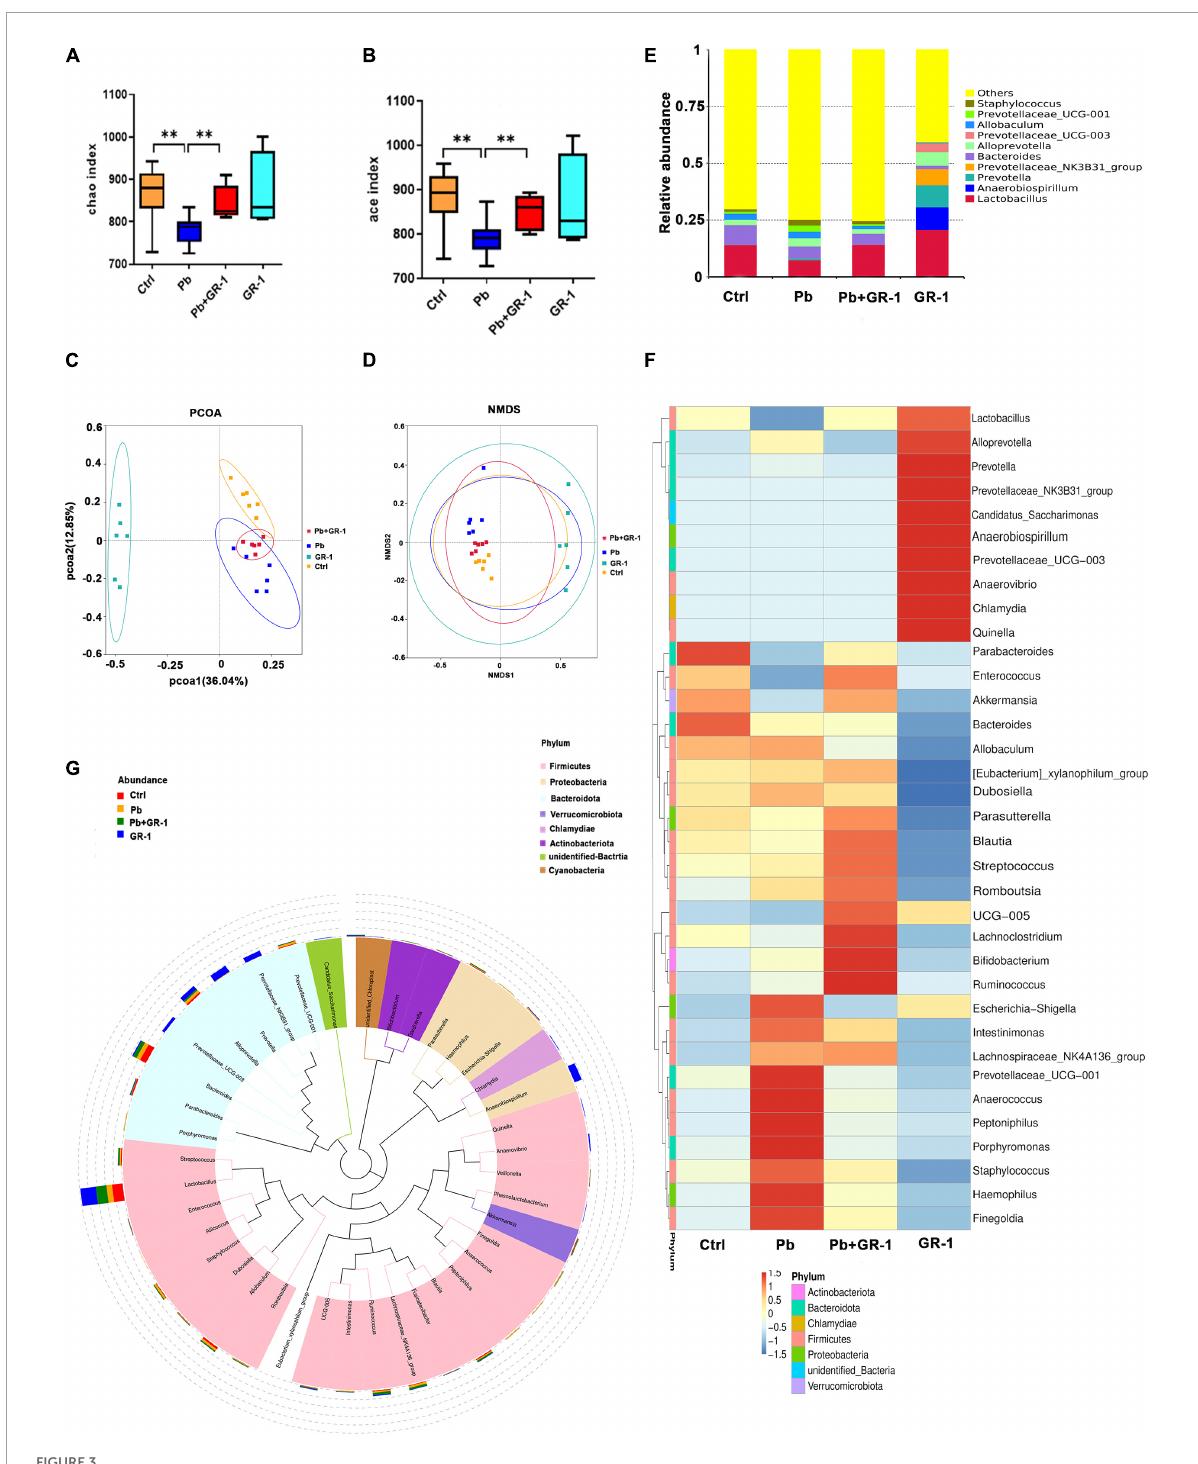
FIGURE3 Lactobacillus rhamnosus GR-1 treatment restored specific microbiota changes in Pb-exposed rats. (A,B) Analysis of alpha diversity in gut microbiota by Chao1 and Ace analysis of the indicated groups ( n = 6). (C) Principal co-ordinates analysis (PCOA) based on Bray–Curtis of gut microbiota of the indicated groups. (D) Non-metric multidimensional scaling (NMDS) analysis based on unweighted UniFrac metrics of gut microbiota of the indicated groups (NMDS = 0.068 < 0.2). (E) The stacked bar chart shows microbiota composition at the phylum level of the indicated groups. (F,G) Heatmap shows the relative abundance of representative microbiota at the genus level of the indicated groups. Abbreviations for microbial names are listed on the right of the graph. Ctrl, non-treated rats; Pb, lead-treated rats; Pb + GR-1, lead and GR-1-treated rats; GR-1, GR-1-treated rats. The data are represented as mean ± SEM; ∗∗ p <